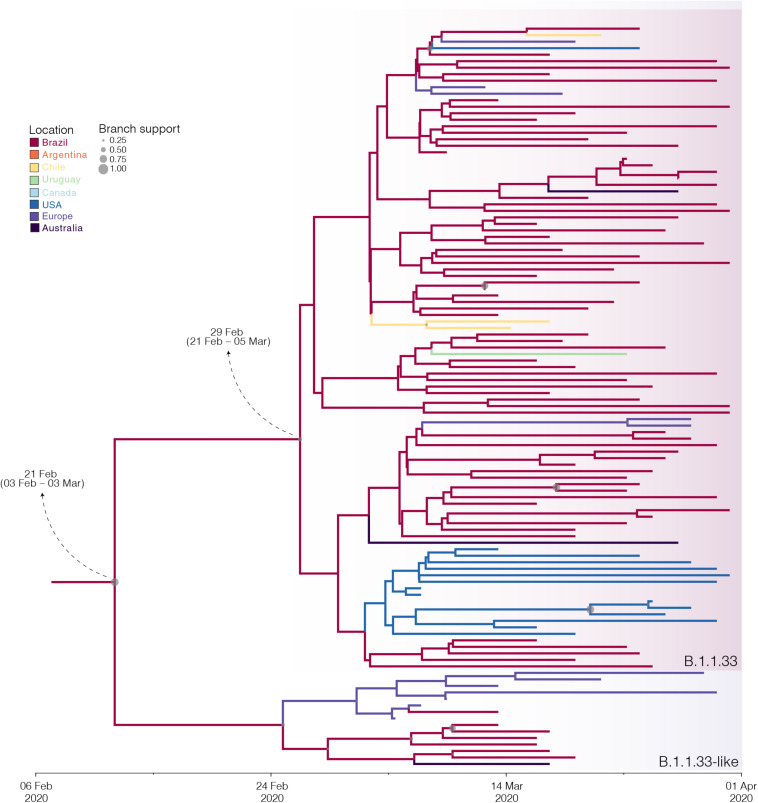
Influence of sampling on the phylogeographic reconstruction of SARS-CoV-2 clade B.1.1.33. Time-scaled Bayesian phylogeographic maximum clade credibility (MCC) tree of a subset of sequences comprising the oldest B.1.1.33-like and B.1.1.33 strains. Branches are colored according to the most probable location state of their descendent nodes as indicated at the legend. Circle size at internal nodes are proportional to the corresponding posterior probability support as indicated at the legend. The inferred TMRCA (based on the median of the posterior heights) and nucleotide substitutions fixed at ancestral key nodes are shown. Shaded boxes highlight the position of the clades B.1.1.33-like and B.1.1.33. The tree is automatically rooted under the assumption of a strict molecular clock, and all horizontal branch lengths are drawn to a scale of years.